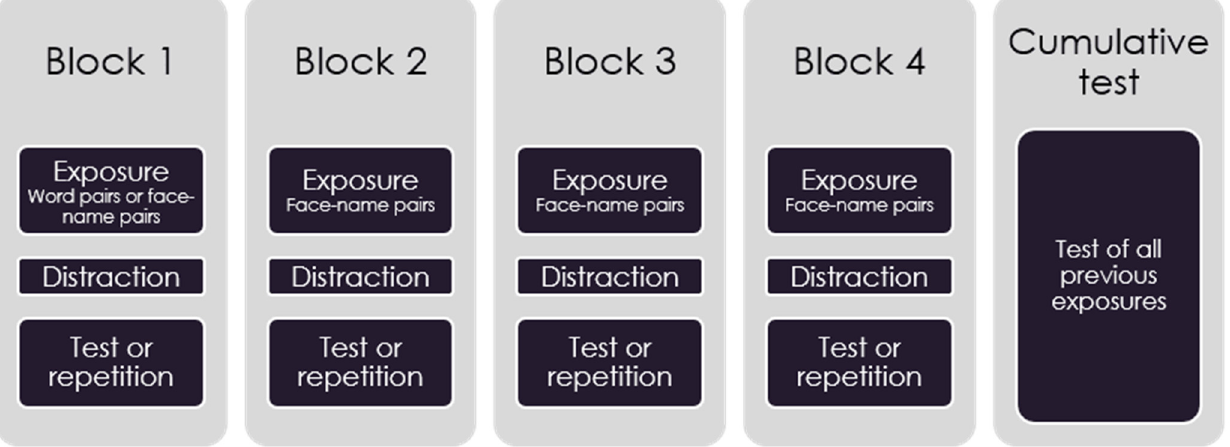
Figure 1. Experimental design.